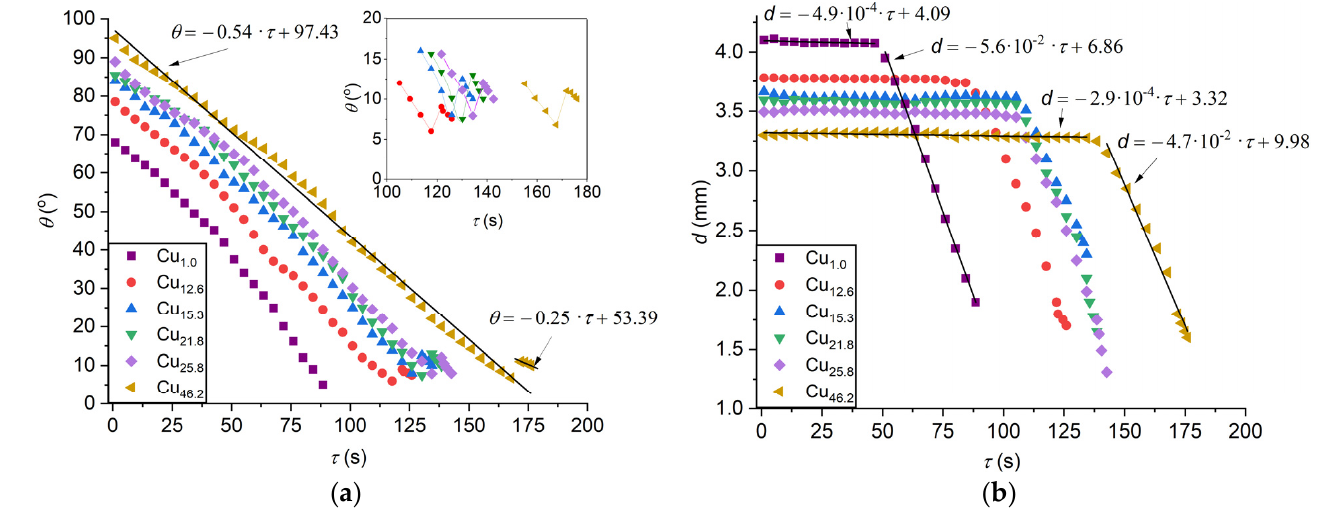
Figure 2. Contact angle ( a ) and diameter ( b ) versus evaporation time for water droplet evaporated in the single-phase regime on copper surfaces heated to 80 ° С .